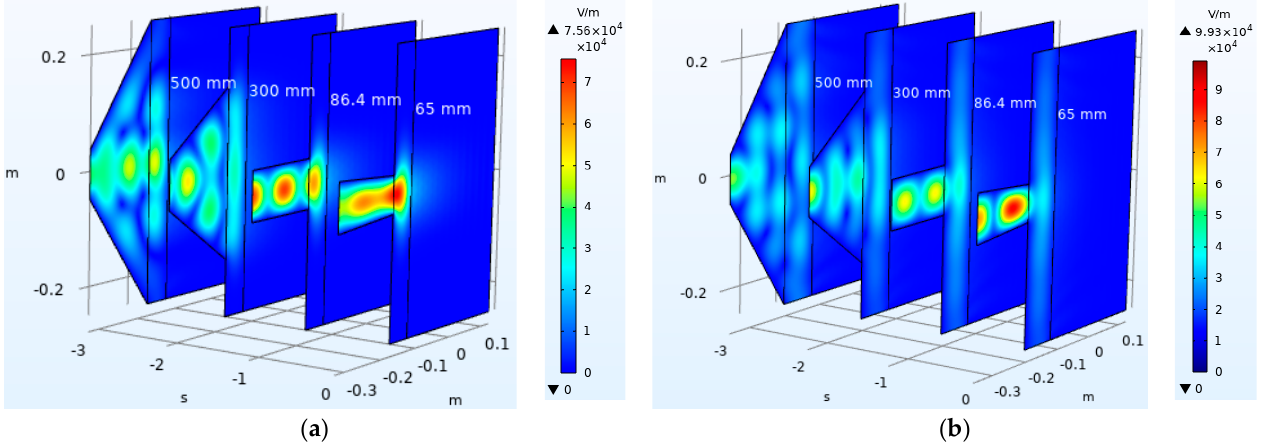
Figure 4. Electric field distribution in the rock sample and waveguide aperture. ( a ) Irradiation distance of 5 cm; ( b ) irradiation distance of 8 cm.